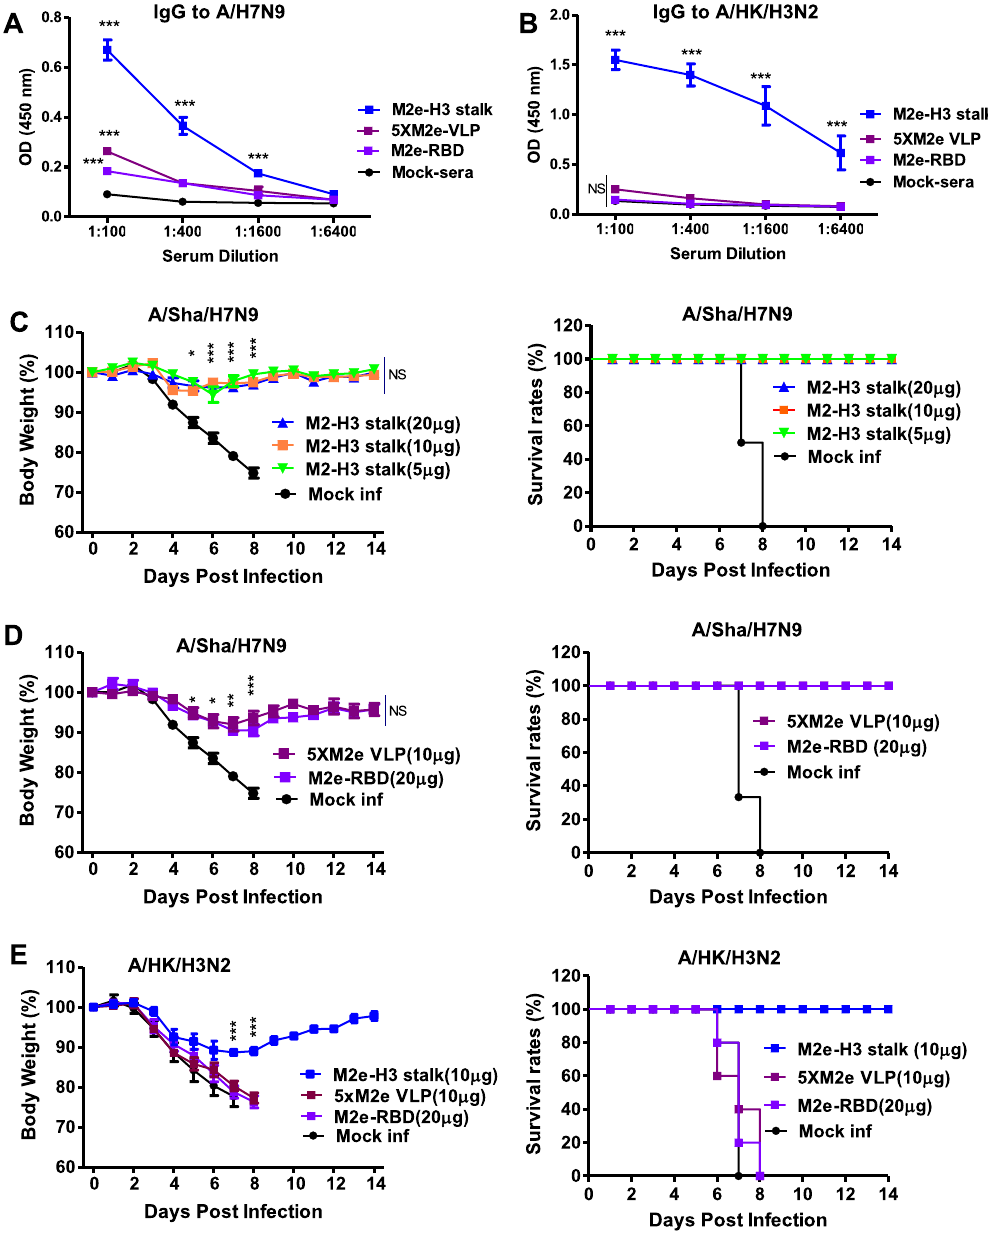
Fig. 9 Adjuvanted M2e-H3 stalk vaccine dosage effects and protective advantages over M2e only vaccines. Young adult mice (6 – 8 weeks old, n = 5) were vaccinated with 5xM2e VLP (10 µg) or M2e-RBD (20 µg) or M2-H3 stalk protein at different doses (5 µg,10 µg, 20 µg). A IgG antibodies speci fi c for A/Sha H7N9 virus. B IgG antibodies speci fi c for A/HK H3N2 virus. C Vaccine dosage effects of M2e-H3 stalk on body weight changes and survival rates after A/Sha/2013 H7N9 (3xLD 50 , 1.1 × 10 4 EID 50 ) virus challenge. D Protective ef fi cacy of M2e only vaccines after A/Sha/2013 H7N9 (3xLD 50 , 1.1 × 10 4 EID 50 ) virus challenge. E Protective ef fi cacy comparison of M2e-H3 stalk and M2e only vaccines after A/HK/1968 H3N2